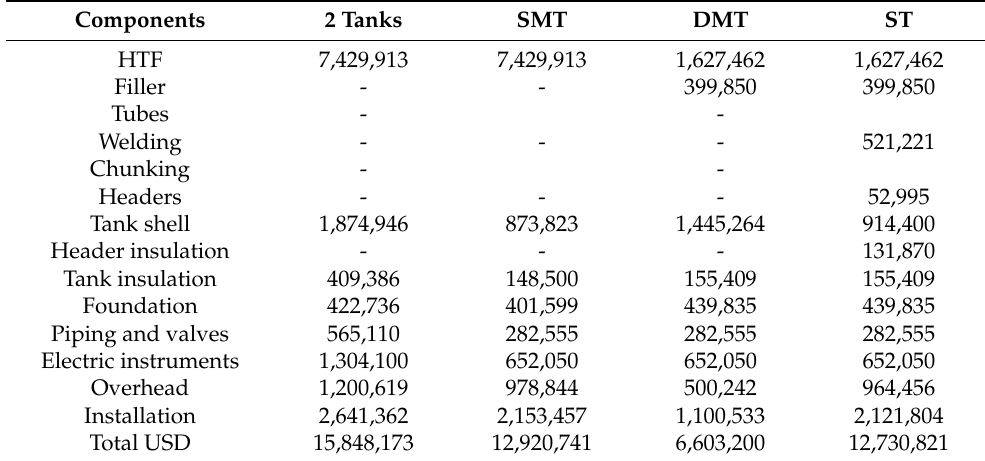
Table 10. Cost breakdown and Specific Cost for various SH-TES for CSP plants